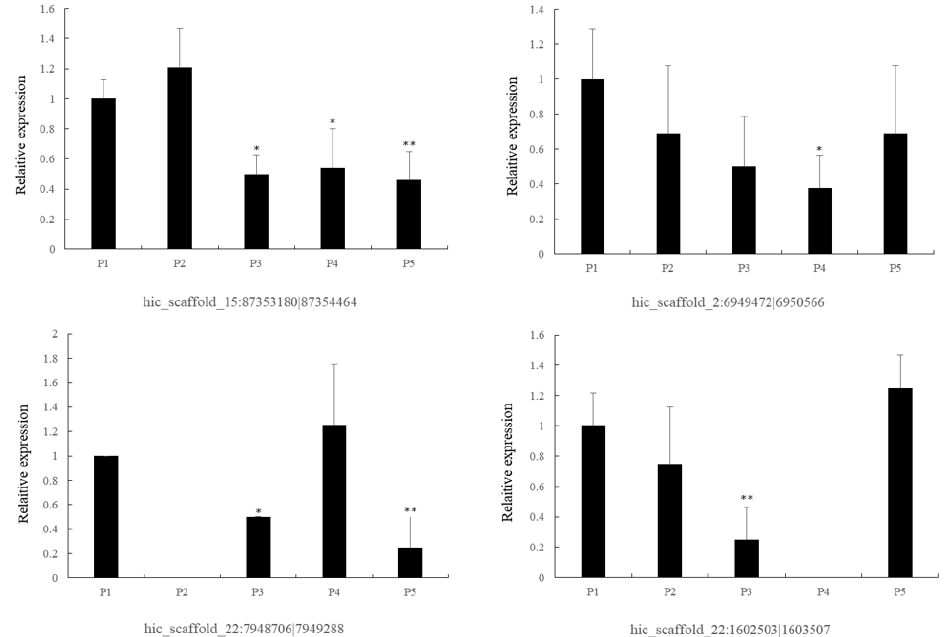
Figure 5. Relative expression of four selected DEcircRNAs measured by RT-qPCR. For RT-qPCR, three replicates were performed. Asterisk on bars indicate significant difference between different stages using t test. Error bars represent standard error of the mean. * p < 0.05, indicates a significant difference. ** p < 0.01, indicates a profoundly significant difference. Bars without asterisk indicates not significant.